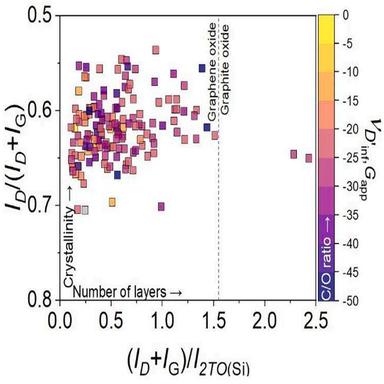
Triple plot showing Raman-based information related to the number of layers (abscissa), crystallinity (ordinate), and oxidation level (color bar) of each of the analyzed GO nanosheets.